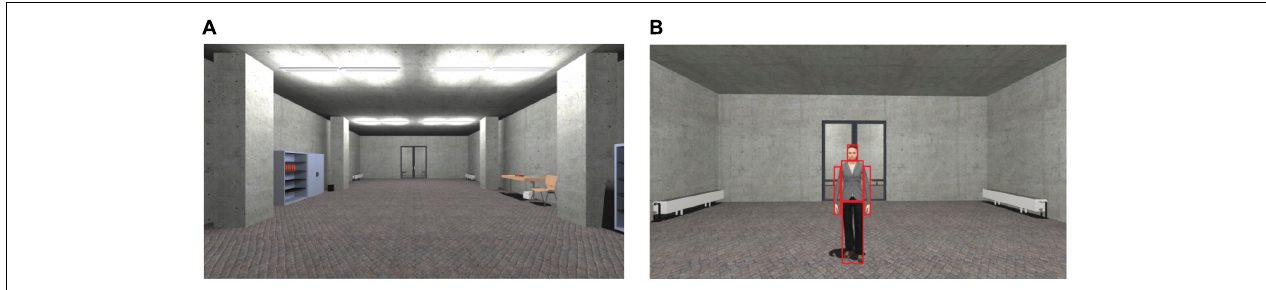
FIGURE 1 | Virtual environment and stimuli. (A) Starting point in the room in which the learning phases took place. (B) Social stimuli (agents) used for social fear conditioning (SFC) with the dynamic social area of interest (red rectangles). For interpretation of the references to color in this figure, the reader is referred to the web version of this